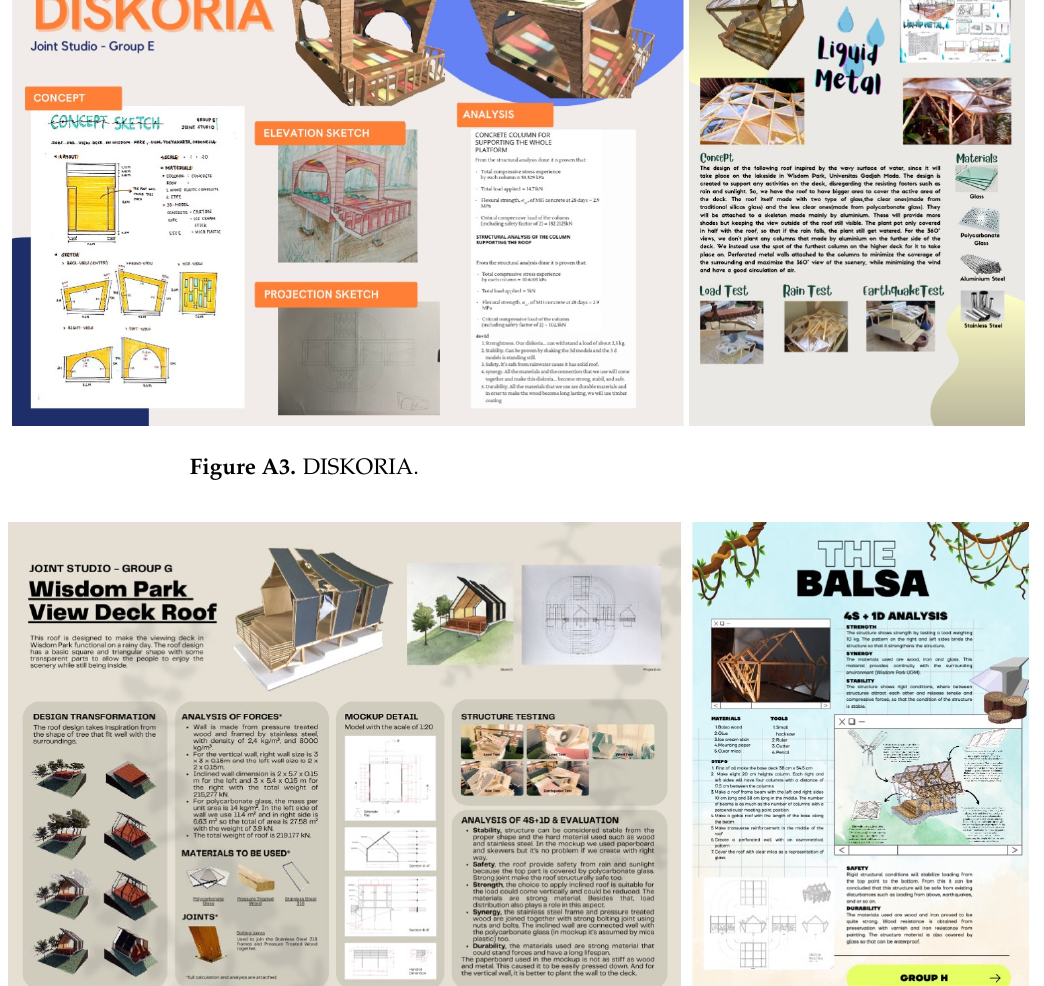
Figure A4. Deck roof.